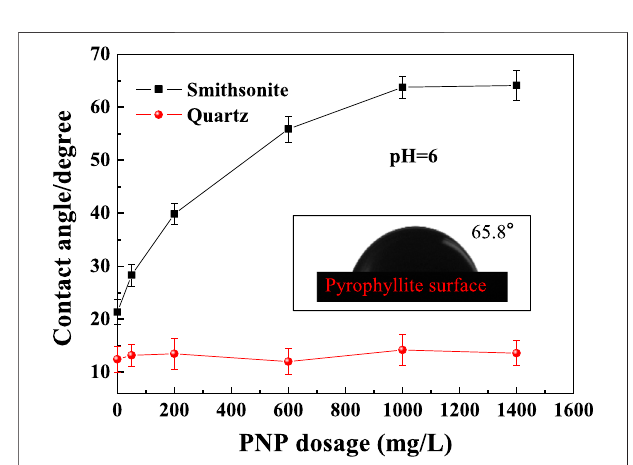
FIGURE 6 | Contact angles for smithsonite and quartz after treatment with a different dosage of